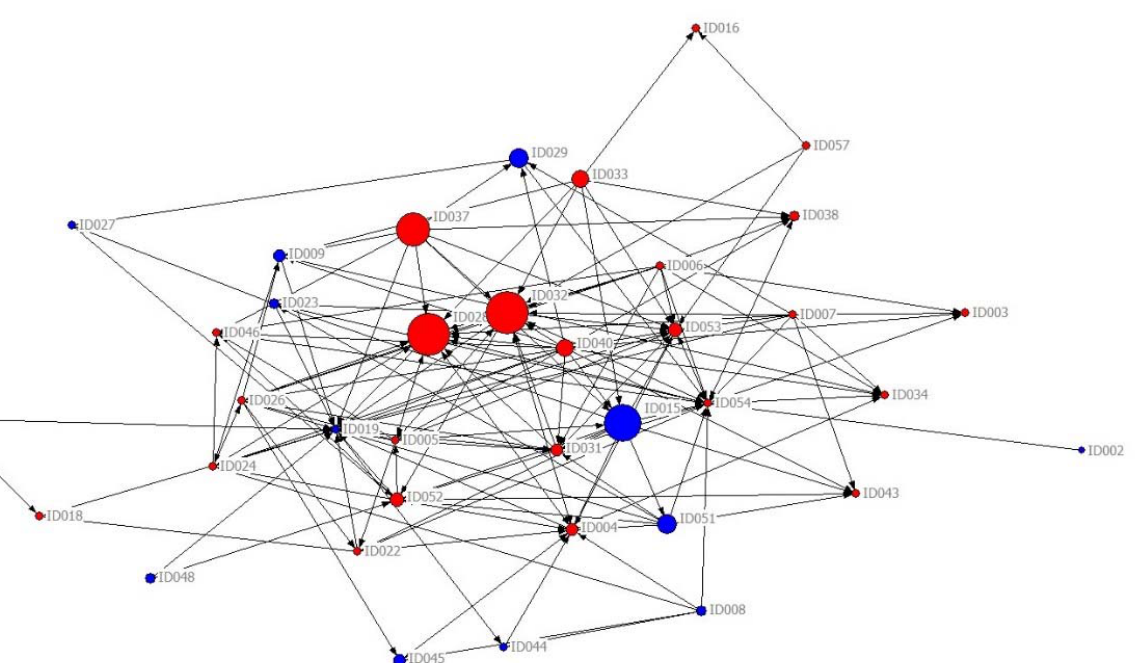
Figure 2. Market knowledge network.